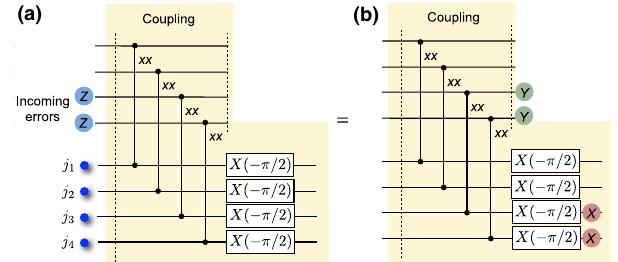
FIG. 13. Dangerous error propagation during the coupling step of the DiVincenzo-Aliferis-type scheme: The circuits show how Z an incoming Z error, resulting, e.g., from a single phase-flip a 3 a 4 error in the encoding step in Fig. 12, is converted into a pair of Y -type errors on the ancilla qubits and furthermore propagate into the data qubit layer, where they result in two bit-flip X errors.